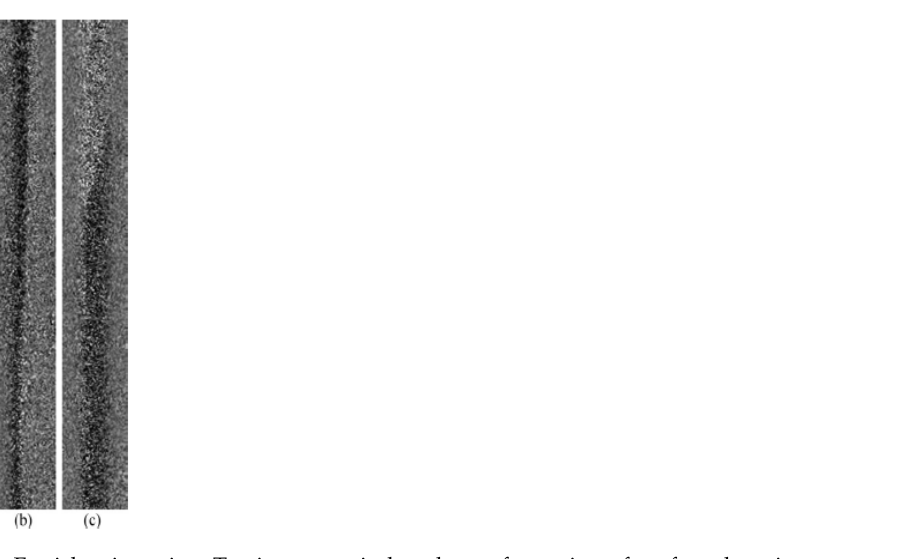
Figure 8. Nucleation and displacement of wedge-shaped domains along the curved surface of mi- crowire in the presence of axial magnetic field. H ax : ( a ) 0.1 Oe, ( b ) 0.2 Oe and ( c ) 0.4 Oe. Reprinted with permission from [54]. To facilitate the analysis, we present three main domain structures that we observed on the surface of the microwire: circular, elliptical and spiral (Figure 9). The circular